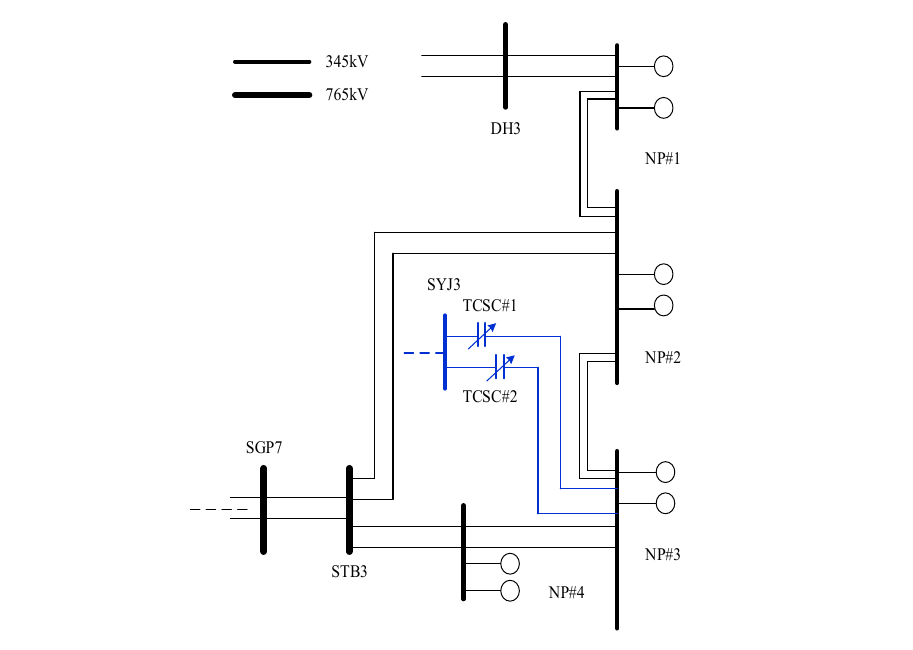
Table 2. FACTS installation and operation status near